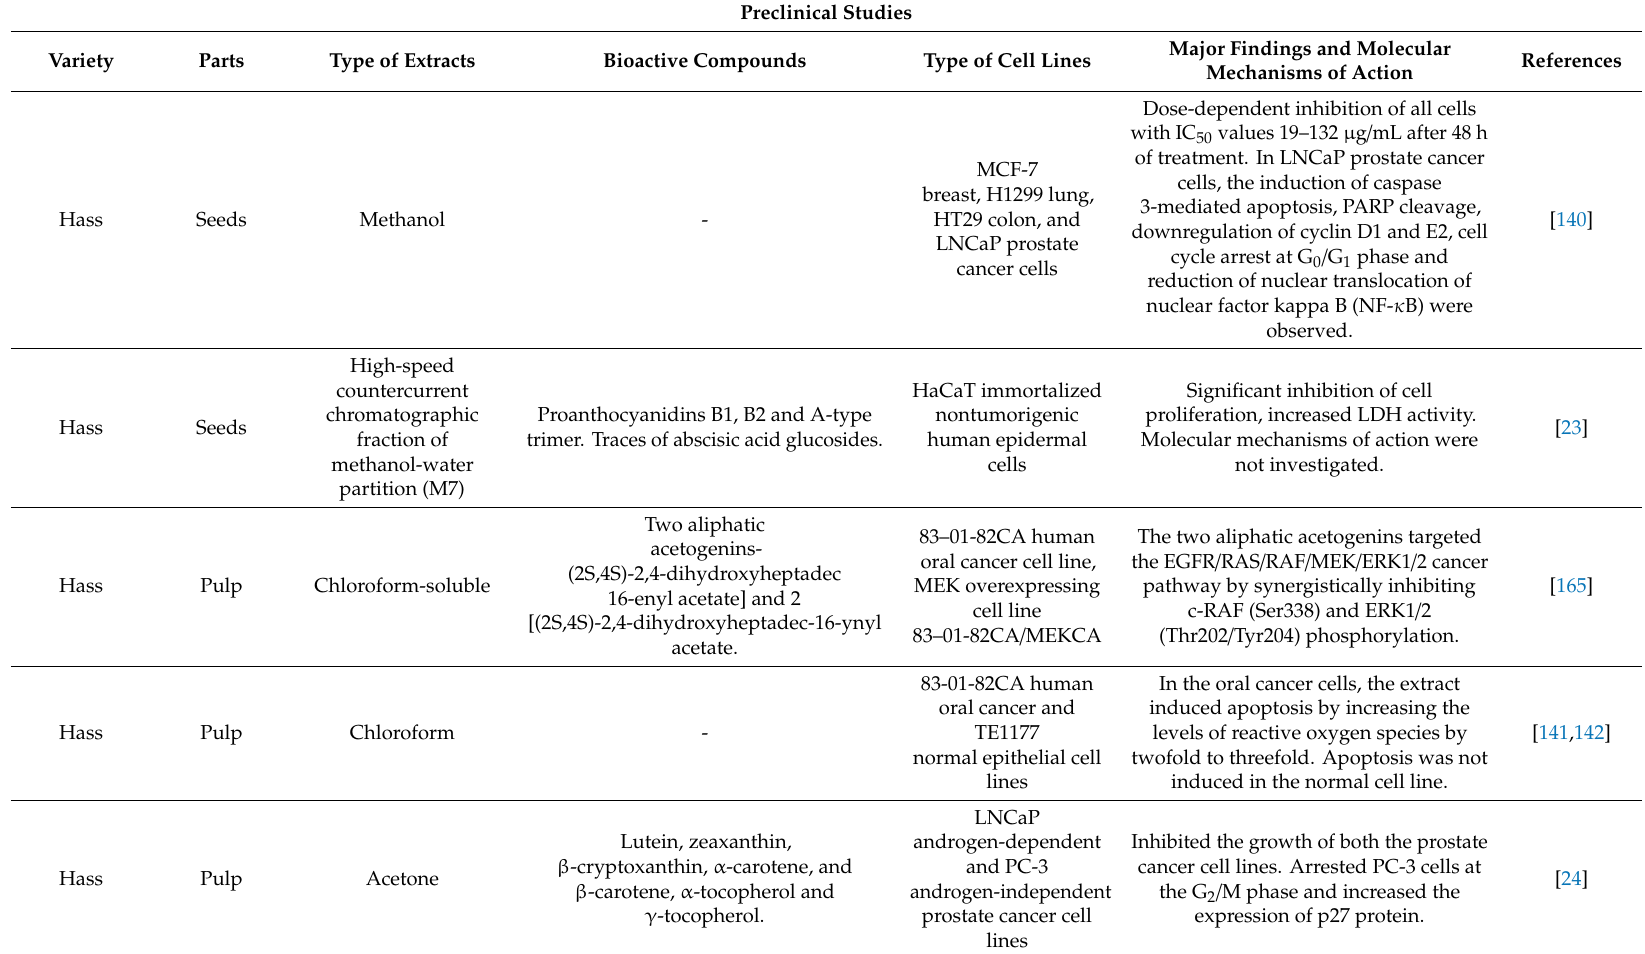
Table 4. Preclinical and clinical studies highlighting the anticancer properties of Persea americana